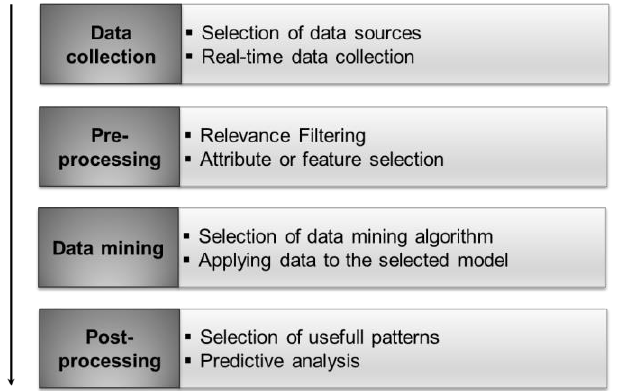
Figure 1. Reality mining phases